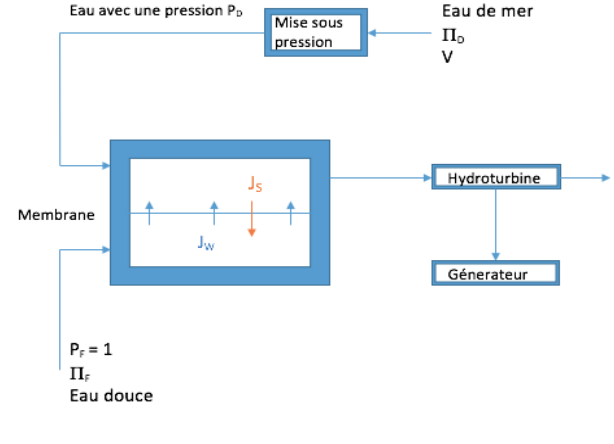
Figure 1. Sketch of Osmotic Plant Balance J S is Salt Flux across the